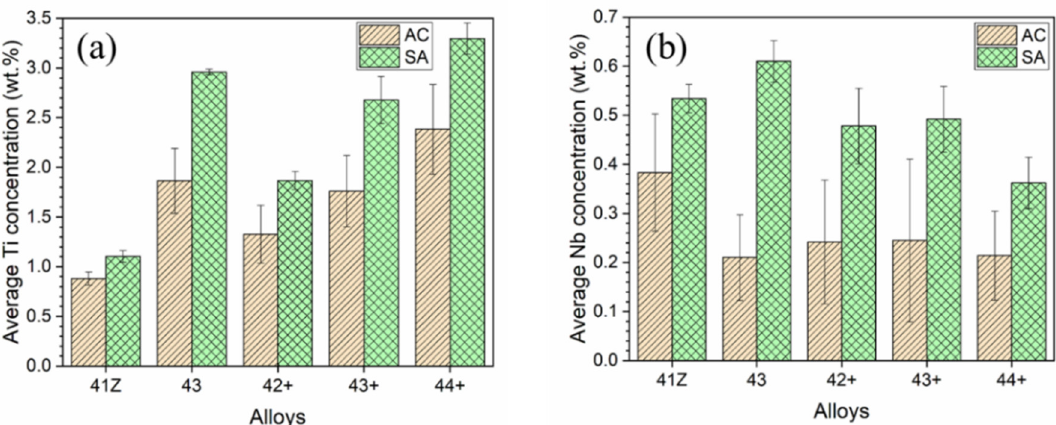
Figure 5. Average concentration of ( a ) Ti and ( b ) Nb in the austenite matrix in as-cast (AC) and solution annealed (SA) conditions, from SEM-EDS analysis.